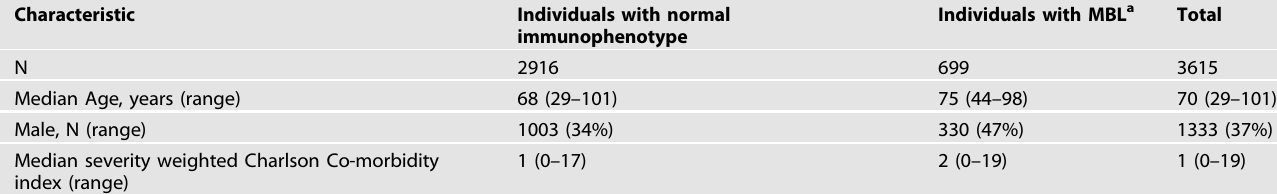
Table 1. Baseline characteristics of all subjects.